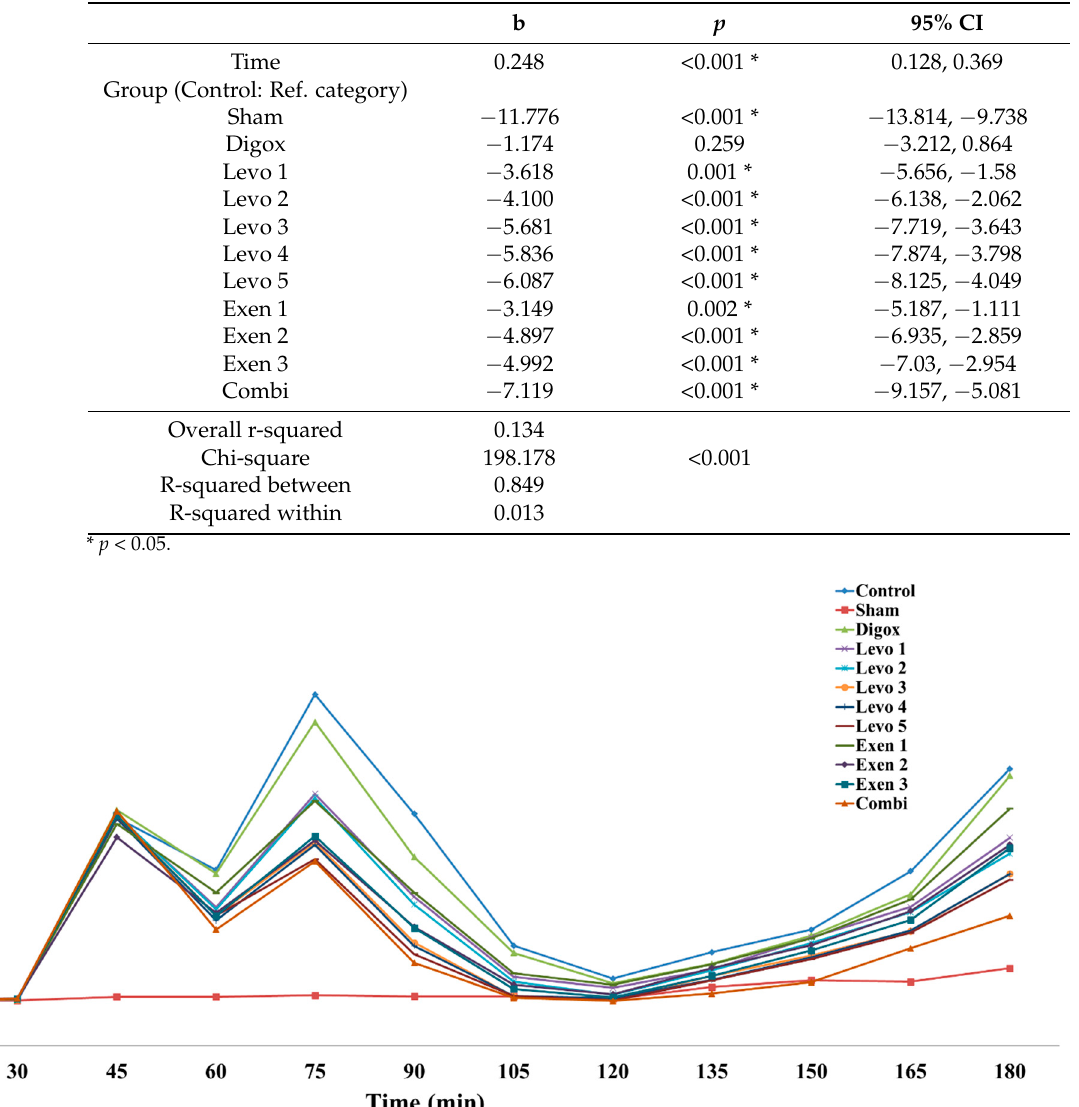
Table 2. Longitudinal analysis for LVEDP for all groups.